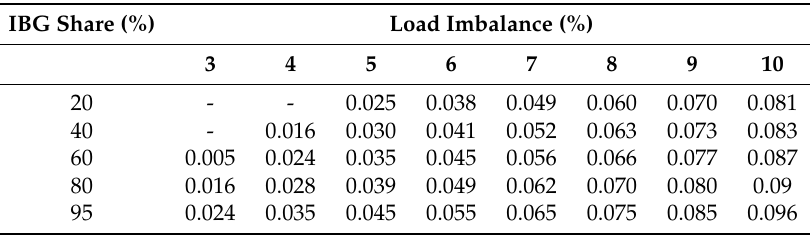
Table 7. Fast power reserve per unit for the European case with the power load as